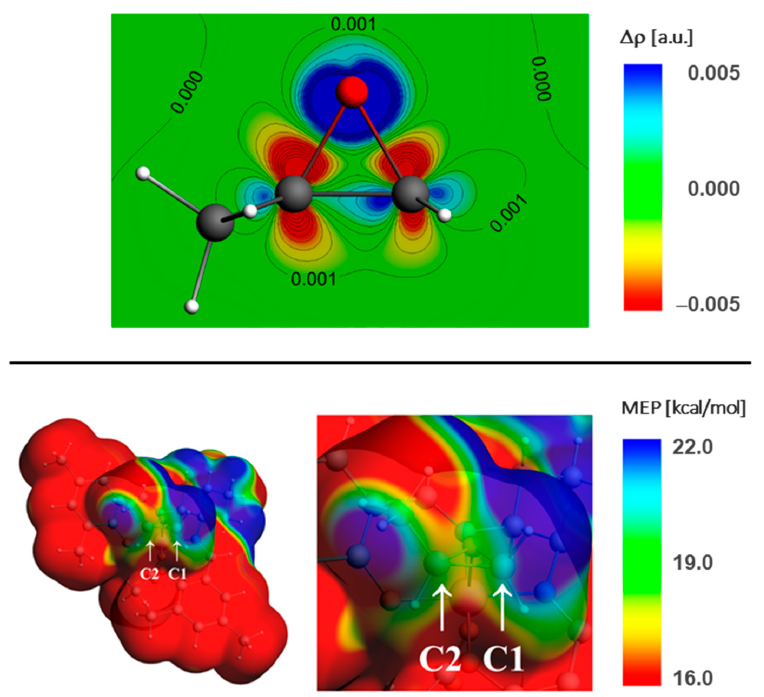
Figure 9. Deformation density, Δ ρ = ρ complex − ( ρ catalyst + ρ epoxide ), colored ‐ contour map (top), and molecular electrostatic potential (bottom) plotted on the electron density surface ( ρ = 0.001 a.u.) for 1a ‐ SS ‐δ‐ trans ‐ R PO(out) complex.